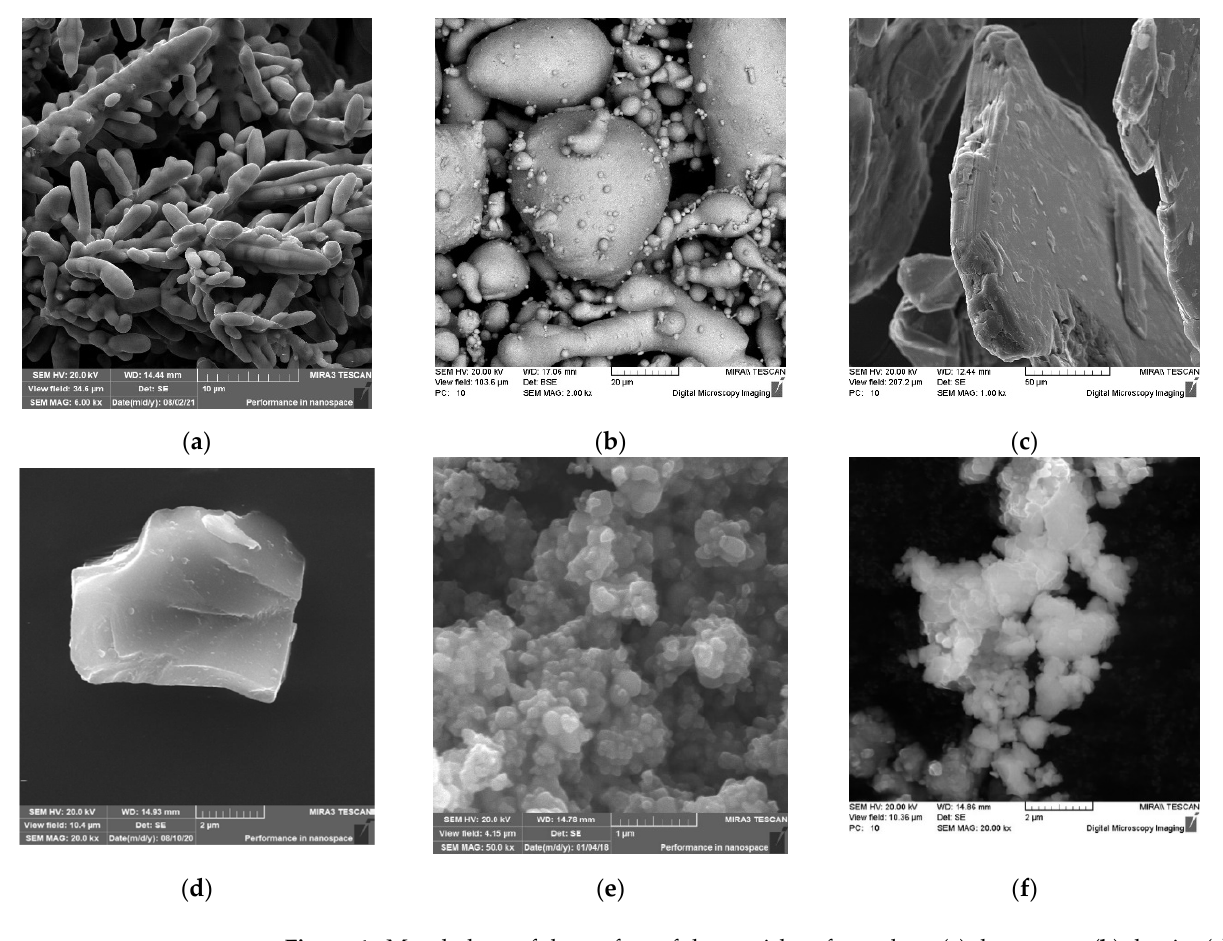
Figure 1. Morphology of the surface of the particles of powders: ( a ) the copper; ( b ) the tin; ( c ) the elemental graphite GE-1; ( d ) the silicon carbide; ( e ) the titanium dioxide; ( f ) the intermetalide